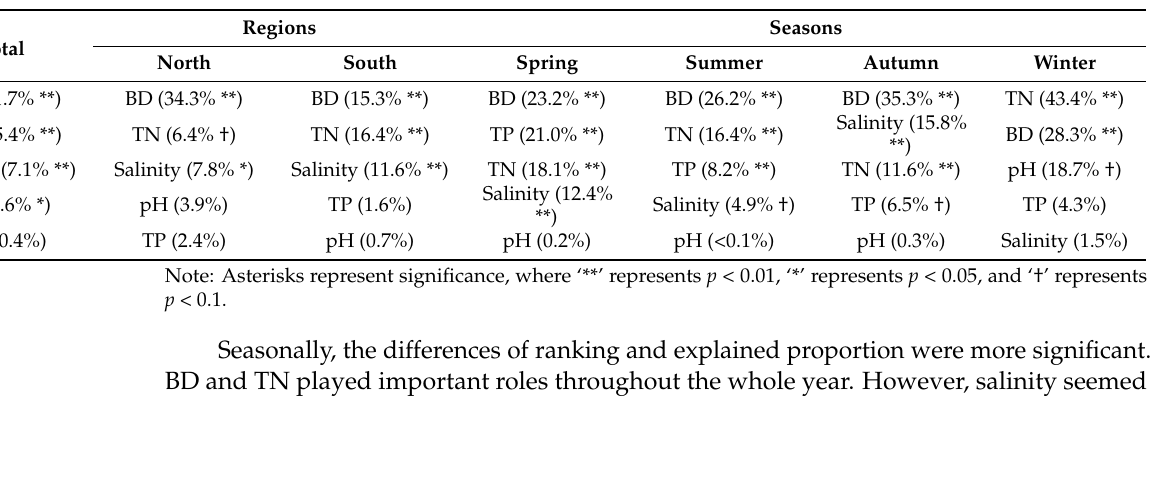
Table 4. Simple effect of soil factors among different regions and